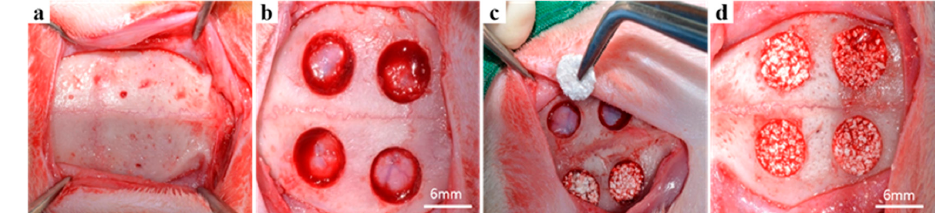
Figure 2. Surgical procedures for the in vivo study: ( a ) parietal bones were exposed by removing periosteum; ( b ) four calvarial defects were formed with a trephine bur (6 mm diameter); ( c ) the four bone grafting materials were randomly placed in defects; and ( d ) all defects were filled with graft materials.